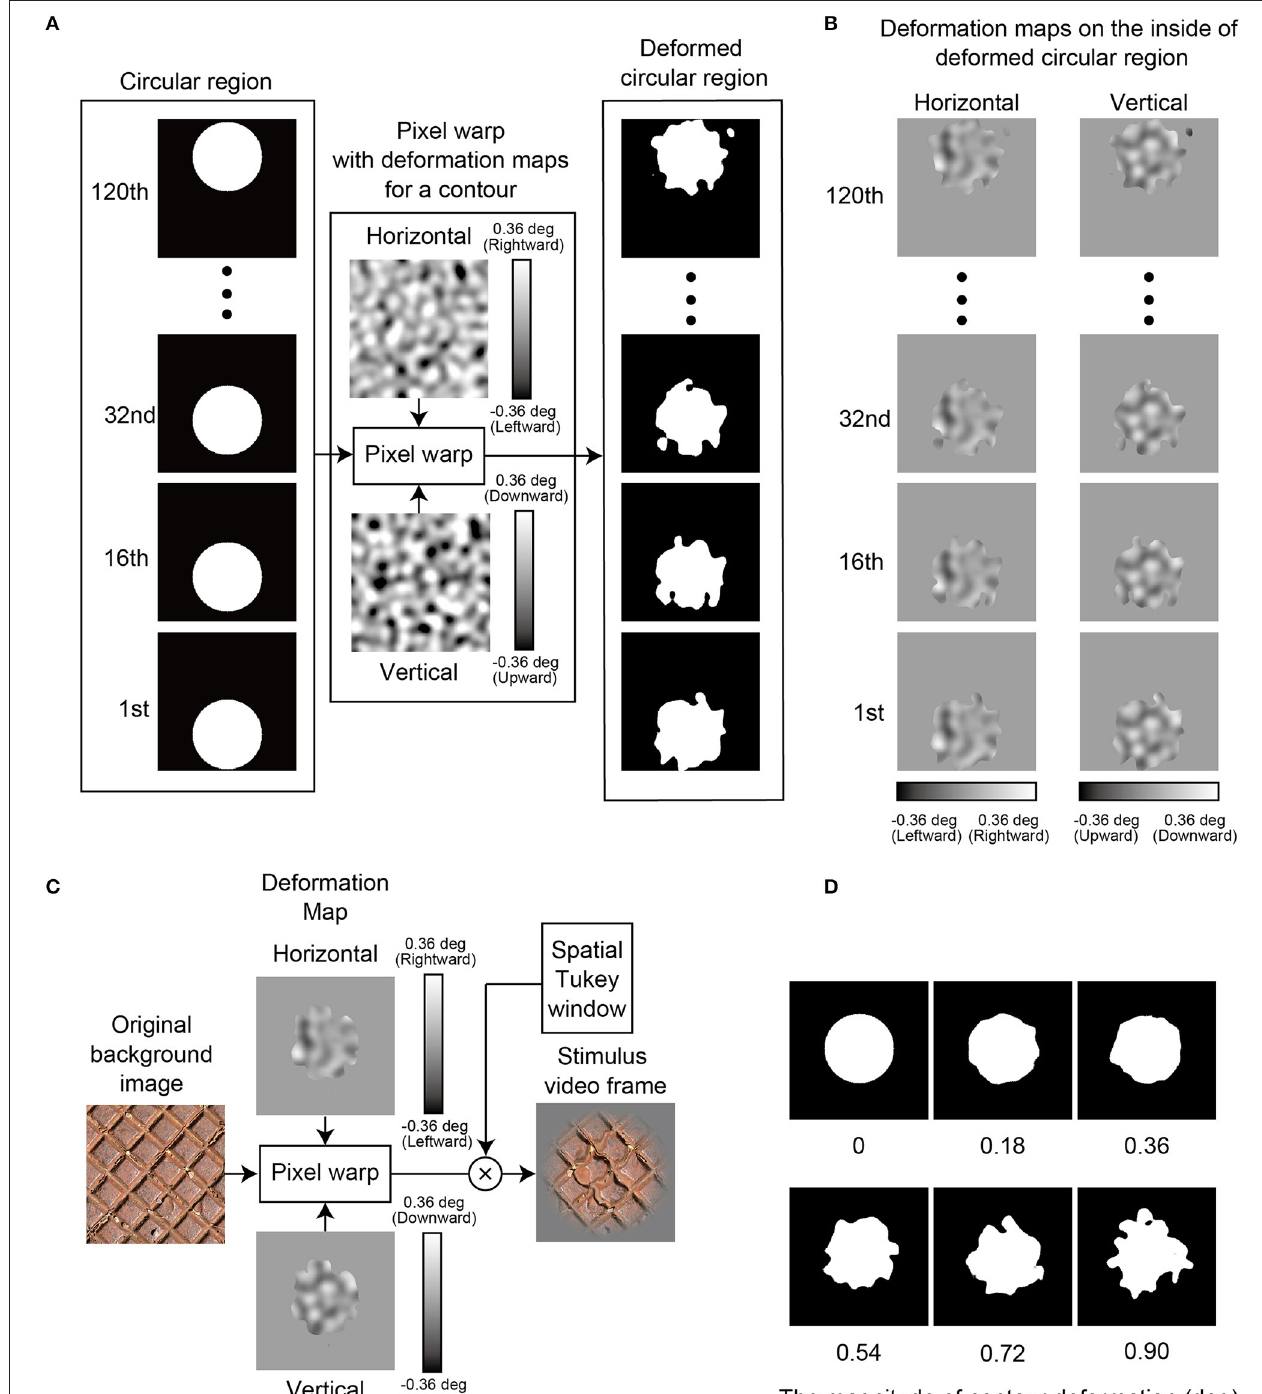
FIGURE 2 | How to make a stimulus image sequence: Experiment 1. (A) The method to deform the contour shape of a circular region at the contour deformation stage. As shown by the vertical luminance bars, a grayscale value in a deformation map denotes the magnitude of a motion vector by which a pixel in a contour of the circular region was moved. Because a circular region was translated upward (the deformation map was kept static), the contour of the circular region was deformed by motion vectors of different magnitude across frames. “Pixel warp” refers to a pixel warp method (Glasbey and Mardia, 1998). (B) Deformation maps as used in the image deformation stage. (C) The method to deform a background image within the deformed circular region at the image deformation stage. As shown by the vertical luminance bars, a grayscale value in a deformation map denotes the magnitude of a motion vector by which a pixel in a background image was